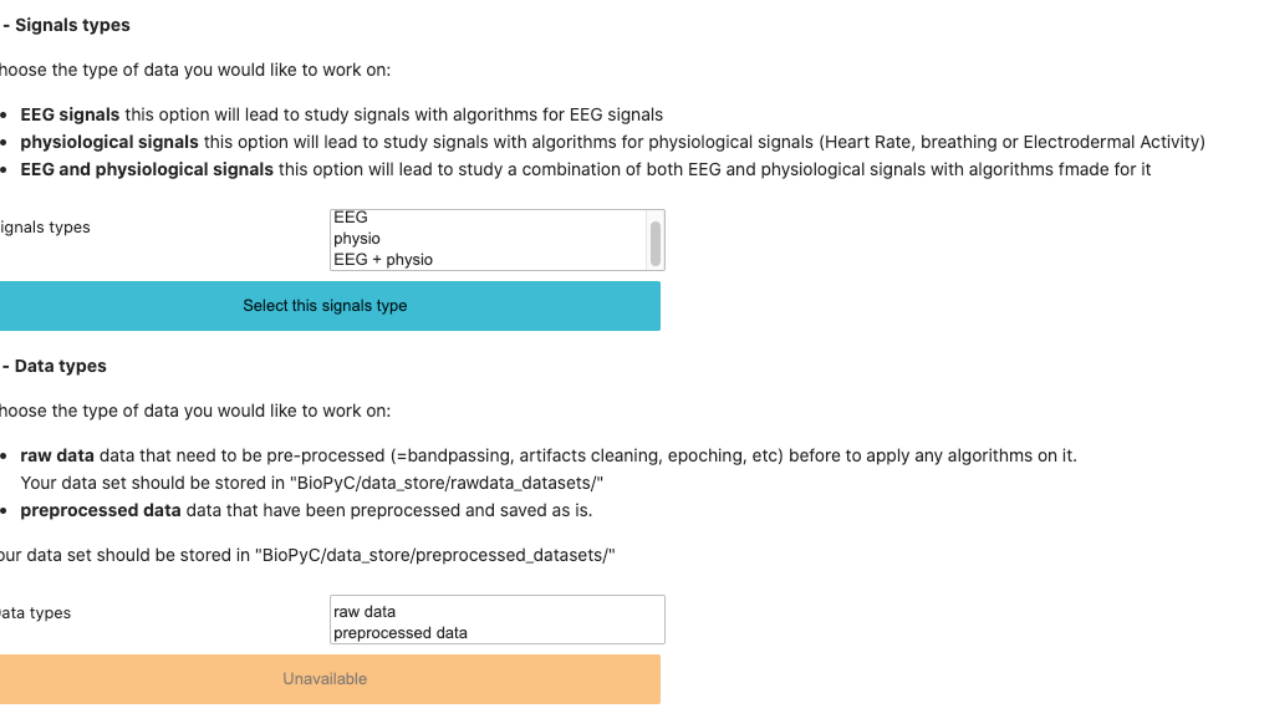
Figure 3. Screenshot of BioPyC’s widgets, i.e., “select multiples” and buttons at the step of selecting the type of data/signals to work on. In BioPyC, a blue button stands for the action to make, when the disabled orange ones stand for future actions to make: orange buttons turn blue when the previous action is